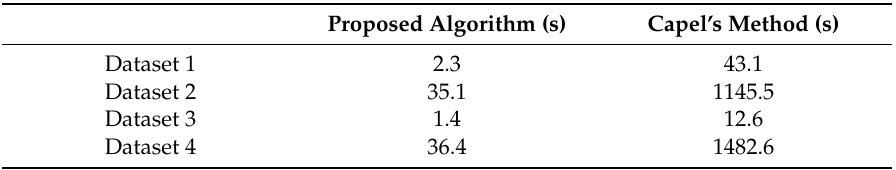
Table 2. Run time for proposed algorithm and Capel’s